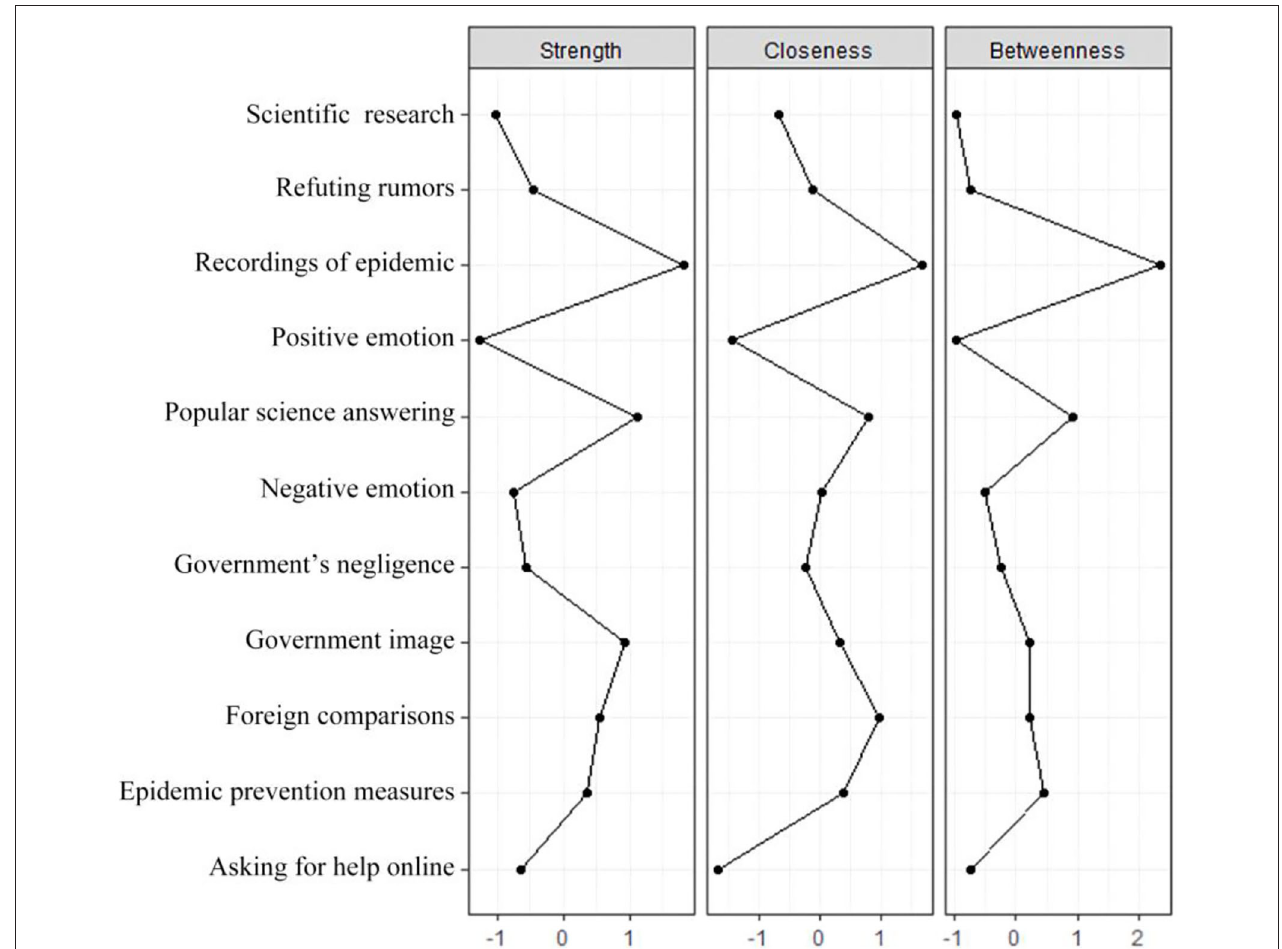
FIGURE 4 | The Weibo topic network centrality Z score